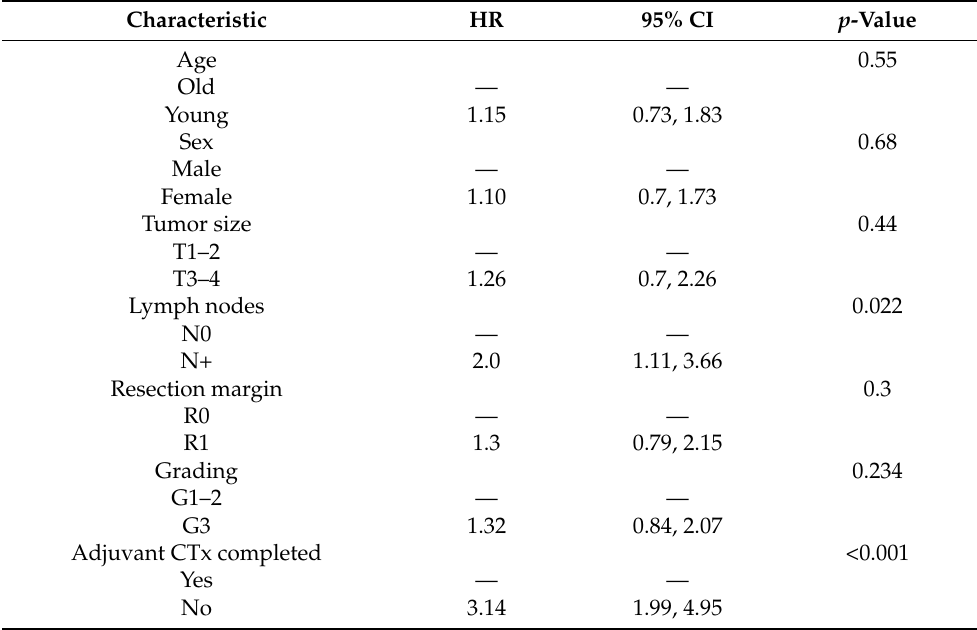
Table 3. Multivariate Cox proportional hazard regression analysis of clinicopathological factors influencing survival after pancreatic cancer resection. The successful completion of chemotherapy, and the lymph node status were independent predictors of survival.